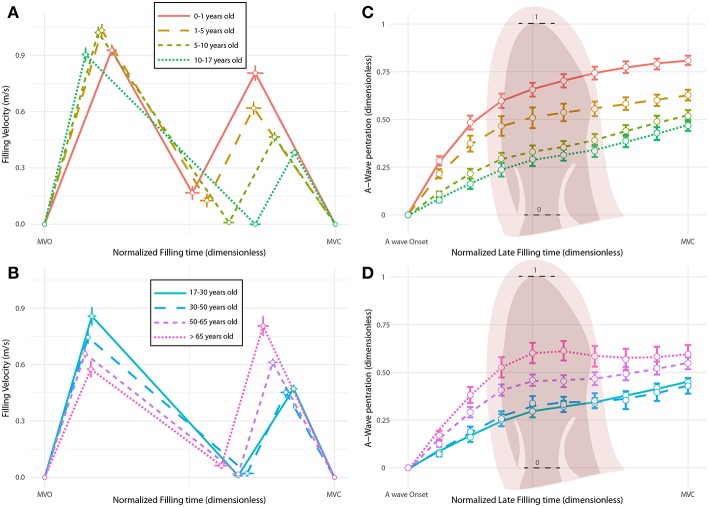
Age-related changes in filling profiles and late-filling wave penetration. (A,B) E and A wave patterns during filling. Horizontal axes represent normalized filling time from mitral valve opening (MVO) to mitral valve closing (MVC). (C,D) Tracking of the A-wave penetration along the LV long axis during the late filling phase, from A-wave onset to mitral valve closing (MVC). Horizontal axes represent the normalized late filling time and vertical axes the normalized long-axis length from the base to the apex. Colors account for age groups.